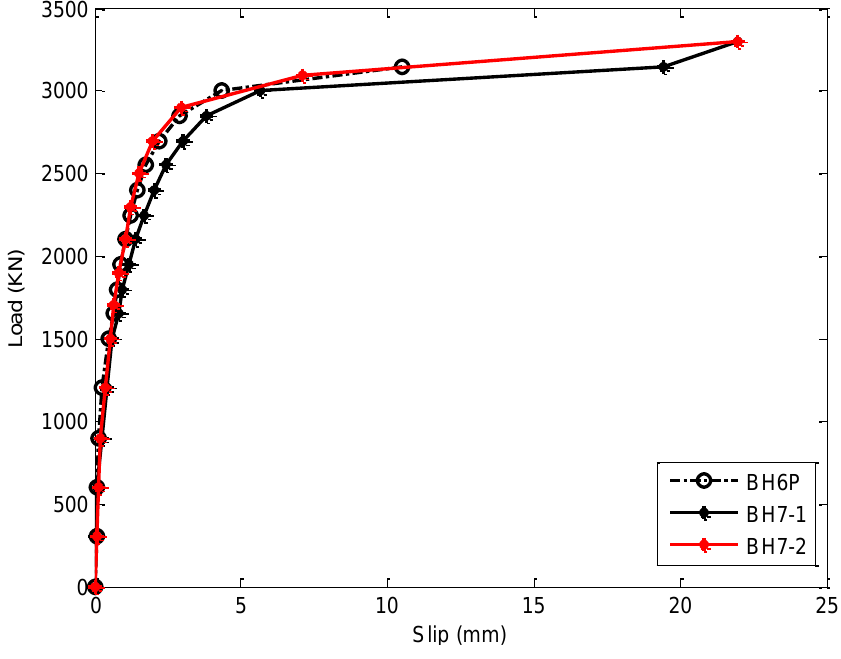
Figure 24. Load – slip relationship. Figure 24. Load–slip relationship.